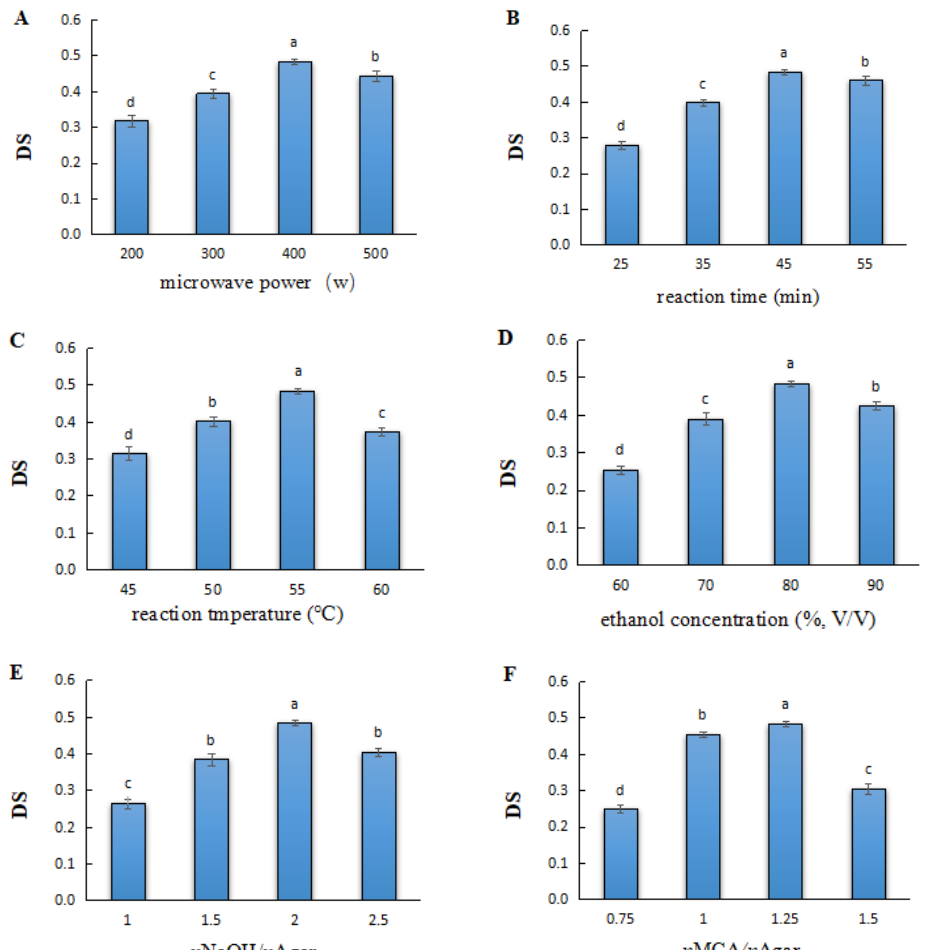
Figure 1. Effect of the main experimental variables in the microwave-assisted method on the DS of carboxymethyl agar: ( A ) microwave power, ( B ) reaction time, ( C ) reaction temperature, ( D ) ethanol concentration, ( E ) amounts of NaOH, and ( F ) monochloroacetic acid (MCA). Different letters above the bars in each histogram indicate significant differences ( p < 0.05).